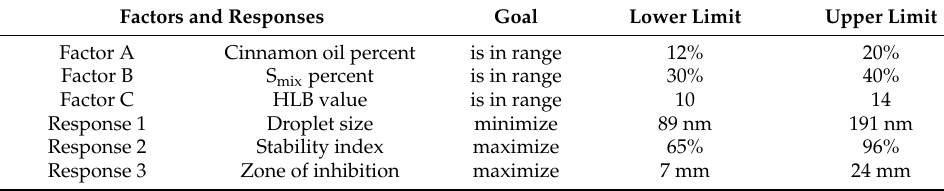
Table 1. Constraints selected for the optimization of the CO-NE